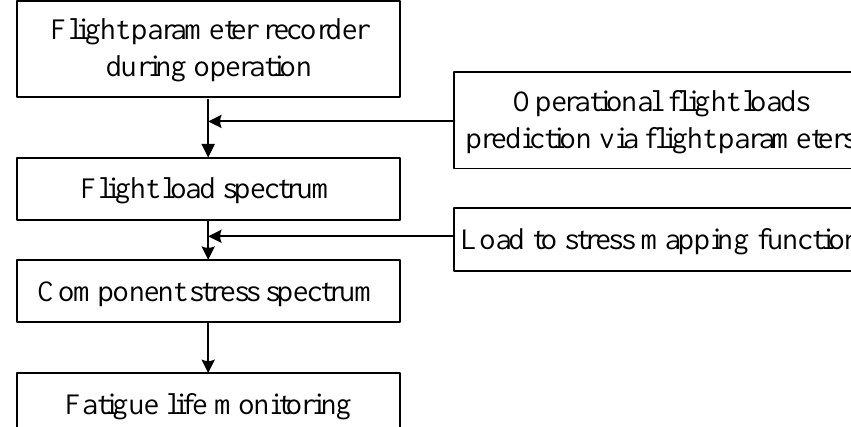
Figure 1. Flowchart of individual aircraft fatigue life monitoring.